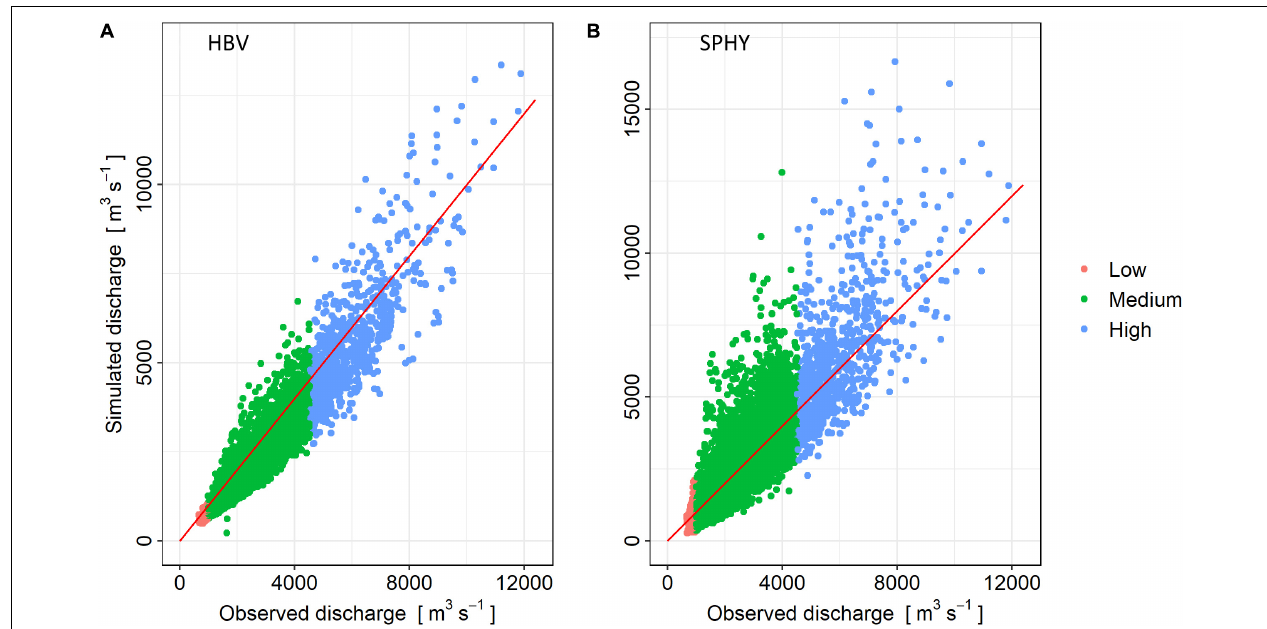
FIGURE 3 | Observed versus modeled daily discharge at Lobith (A) HBV and (B) SPHY for the period between 1951 and 2000. Colors indicate three ranges based on observed quantiles: “Low” ( < 5%, red), “Medium” (5–95%, green), and “High” ( > 95%). The solid red line represents the 1:1 slope. TABLE 1 | Performance index for HBV and SPHY model on a daily time scale. HBV